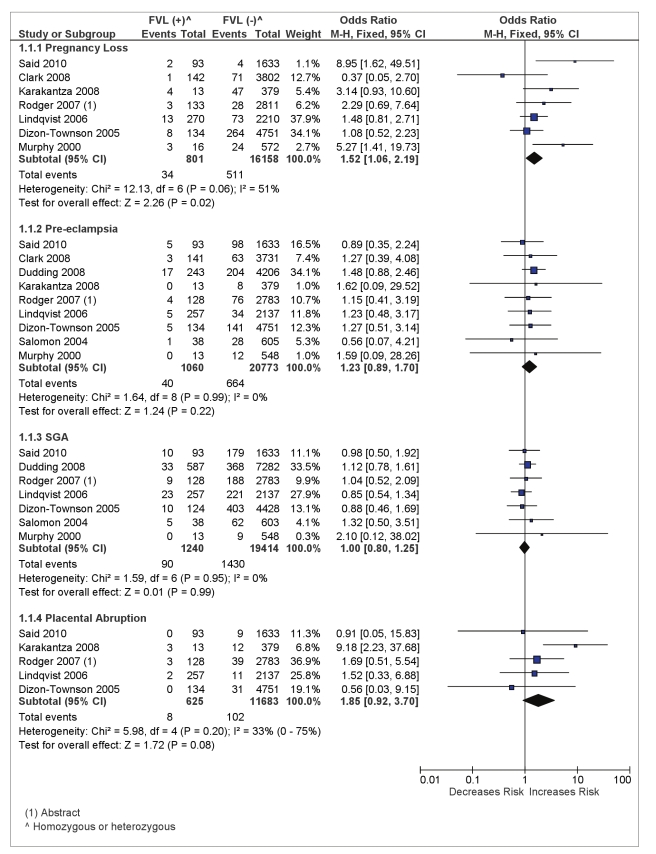
Odds of placenta-mediated pregnancy complications in FVL (homozygous or heterozygous)-positive women.